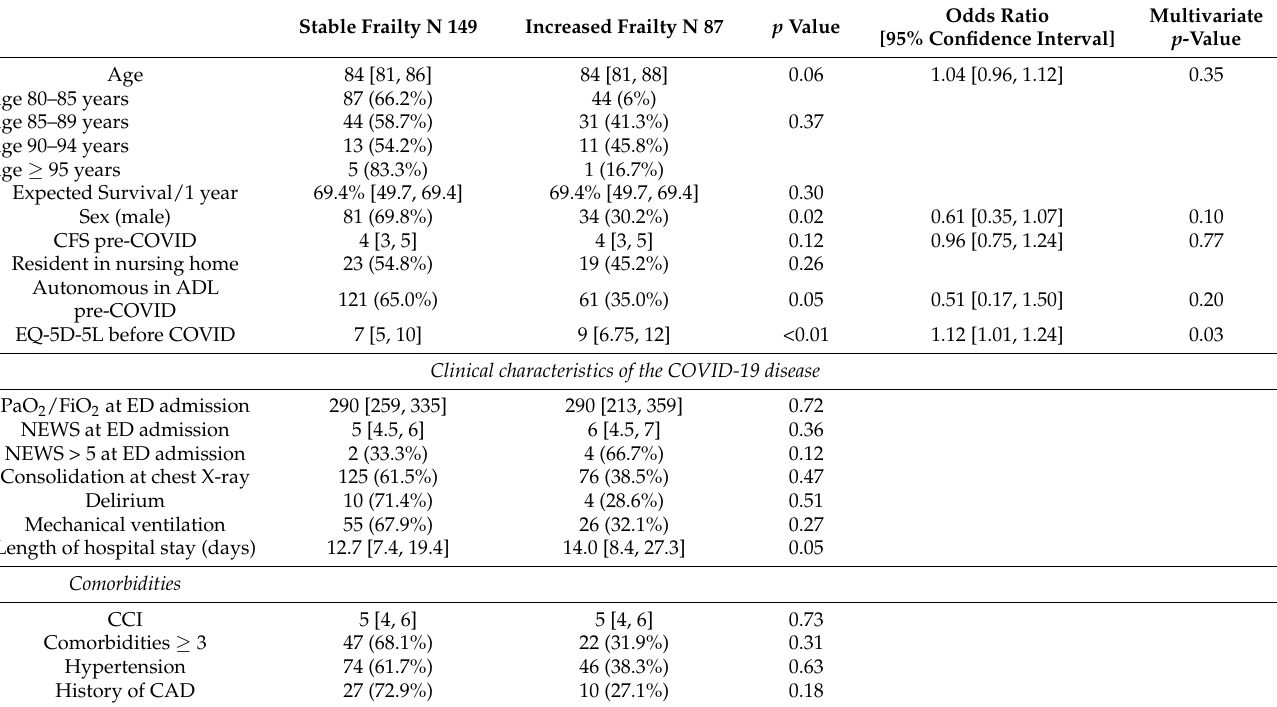
Figure 1. Cox regression analysis for patients with different frailty statuses (based on the clinical frailty scale) measured at the time of the index COVID-19 hospitalization. The analysis was adjusted for age, sex, life expectancy at 1 year, relevant clinical parameters, length of hospitalization, and comorbidities. The expected survival was based on the data obtained from the Italian Population Registry in 2019. Table 2. Clinical characteristics of enrolled patients according to increase in frailty as assessed by the Clinical Frailty Scale at 1-year follow-up. Logistic model chi-square = 16.167, p < 0.001; log-likelihood = 294.693. Expected survival at 1 year was calculated based on the data obtained from the Italian Registry of the population in 2019. Time was calculated from index ED admission for COVID. Proportions are reported as row